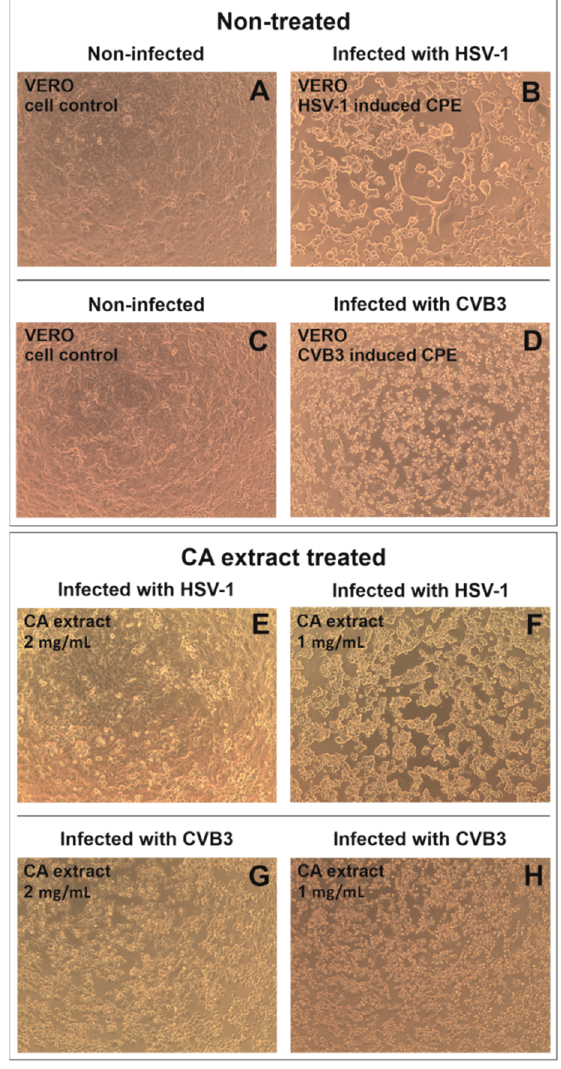
Figure 2. The influence of CA extract on HSV-1 or CVB3-induced cytopathic effect (CPE) formation in infected VERO cells; ( A and C ) non-infected VERO cells, ( B ) HSV-1 induced CPE in VERO cells, ( D ) CVB3 induced CPE in VERO cells, the influence of CA extract 2 mg/mL ( E ) and 1 mg/mL ( F ) on HSV-1 induced CPE in VERO cells, the influence of CA extract 2 mg/mL ( G ) and 1 mg/mL ( H ) on CVB3 induced CPE in VERO cells. (Magnification × 100).